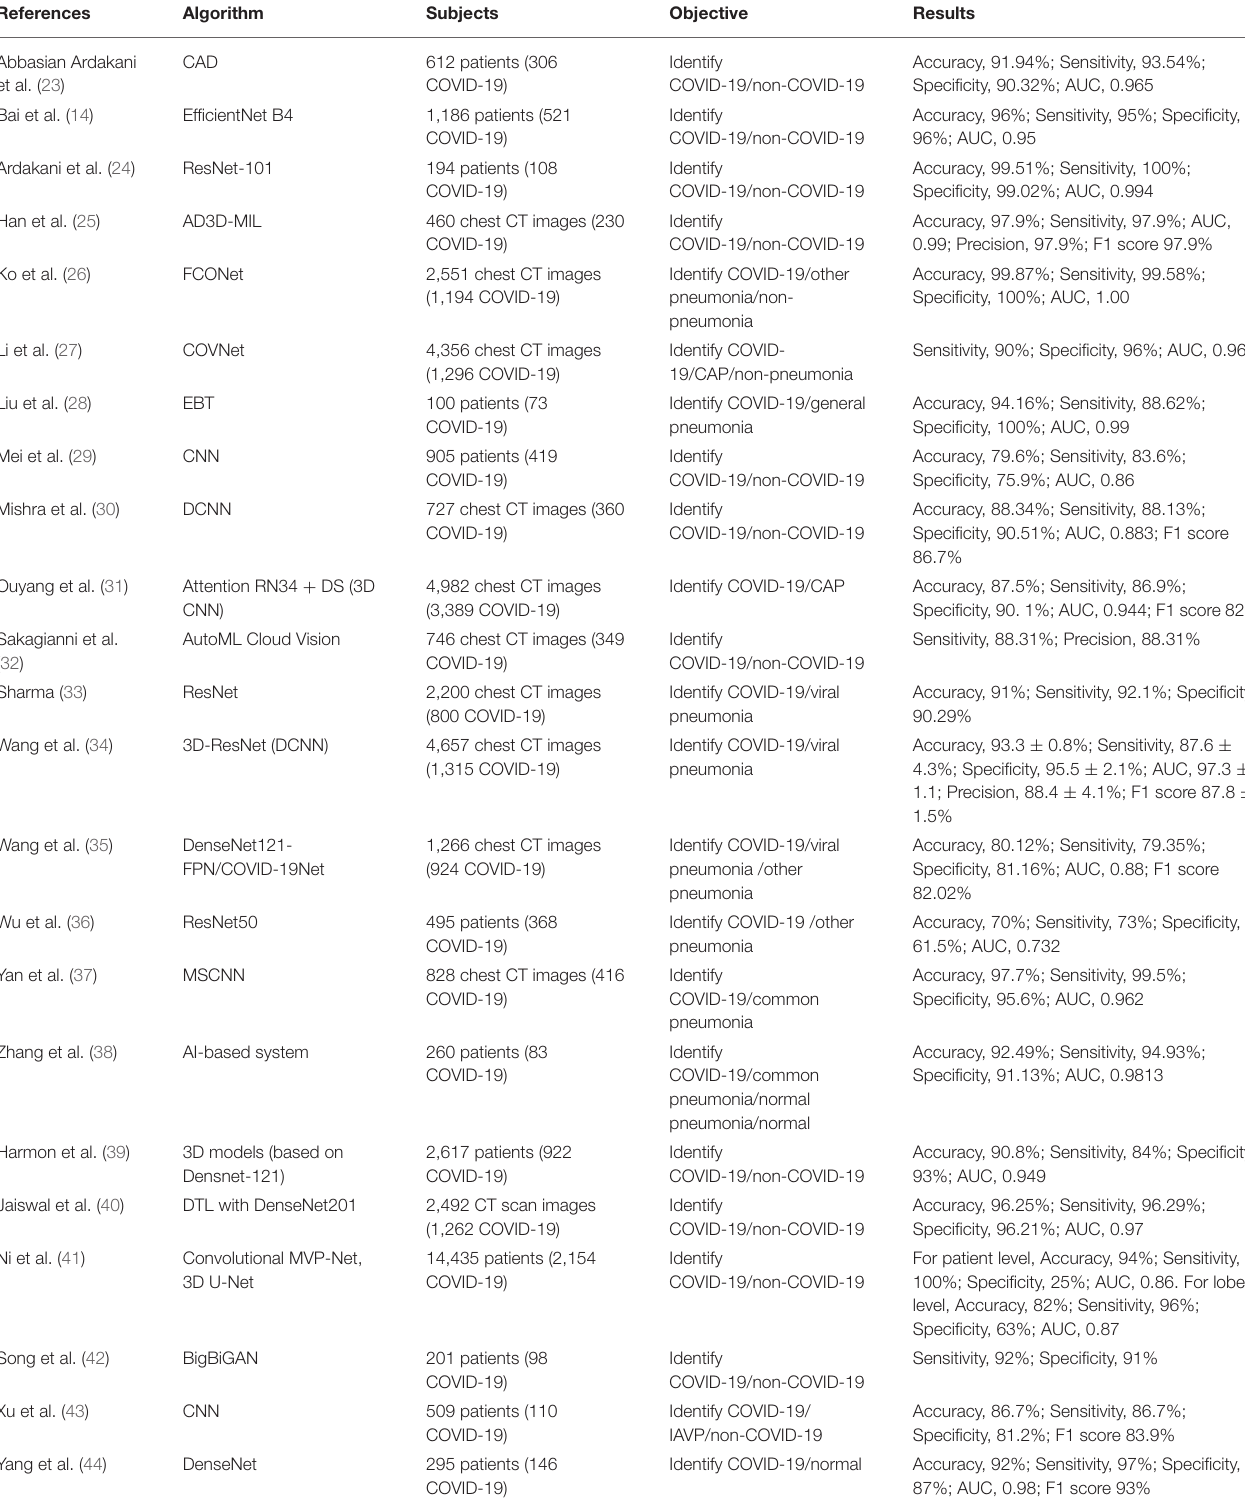
TABLE 2 | Application of AI in using chest CT images to diagnose